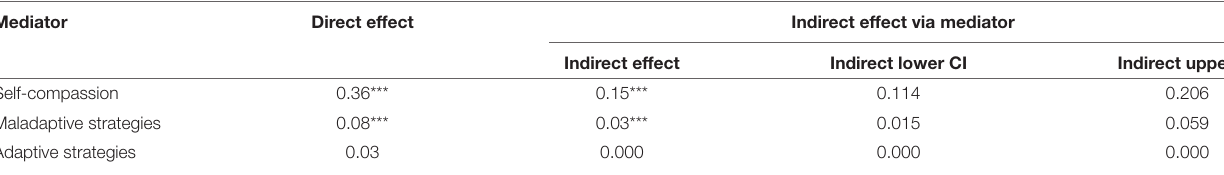
TABLE 3 | Summary of mediation analyses on direct and indirect effects of Corona Disease Anxiety on internet addiction ( n = 1,008).